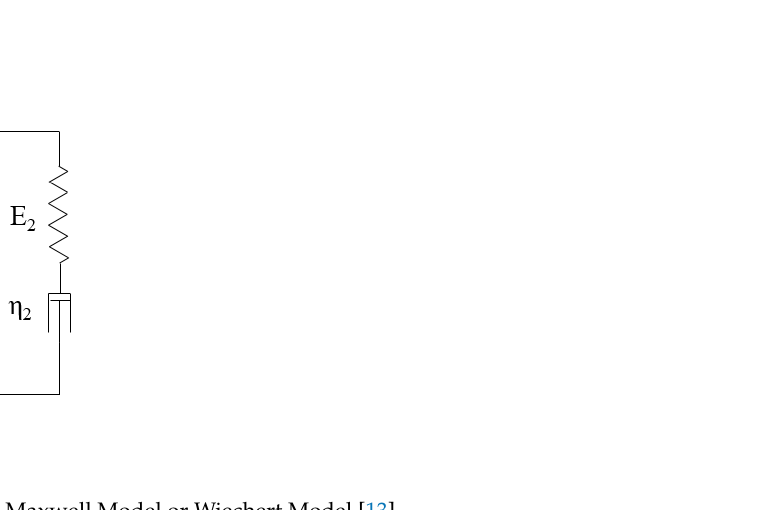
Table 1. Effect of different PES content on the T g onset of the polymer blend.